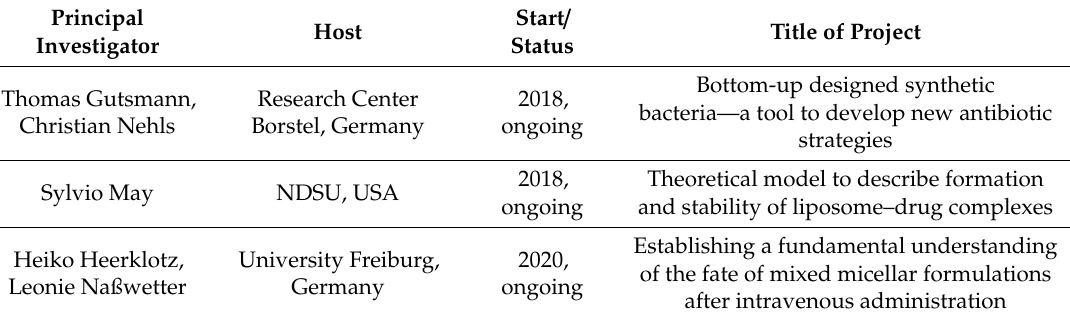
Table 7. Overview of PRC-funded projects (2017–now) covering basic phospholipid research. Principal Investigator Sylvio May NDSU, USA